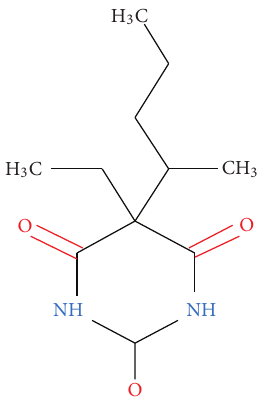
F 1: Chemical structure of